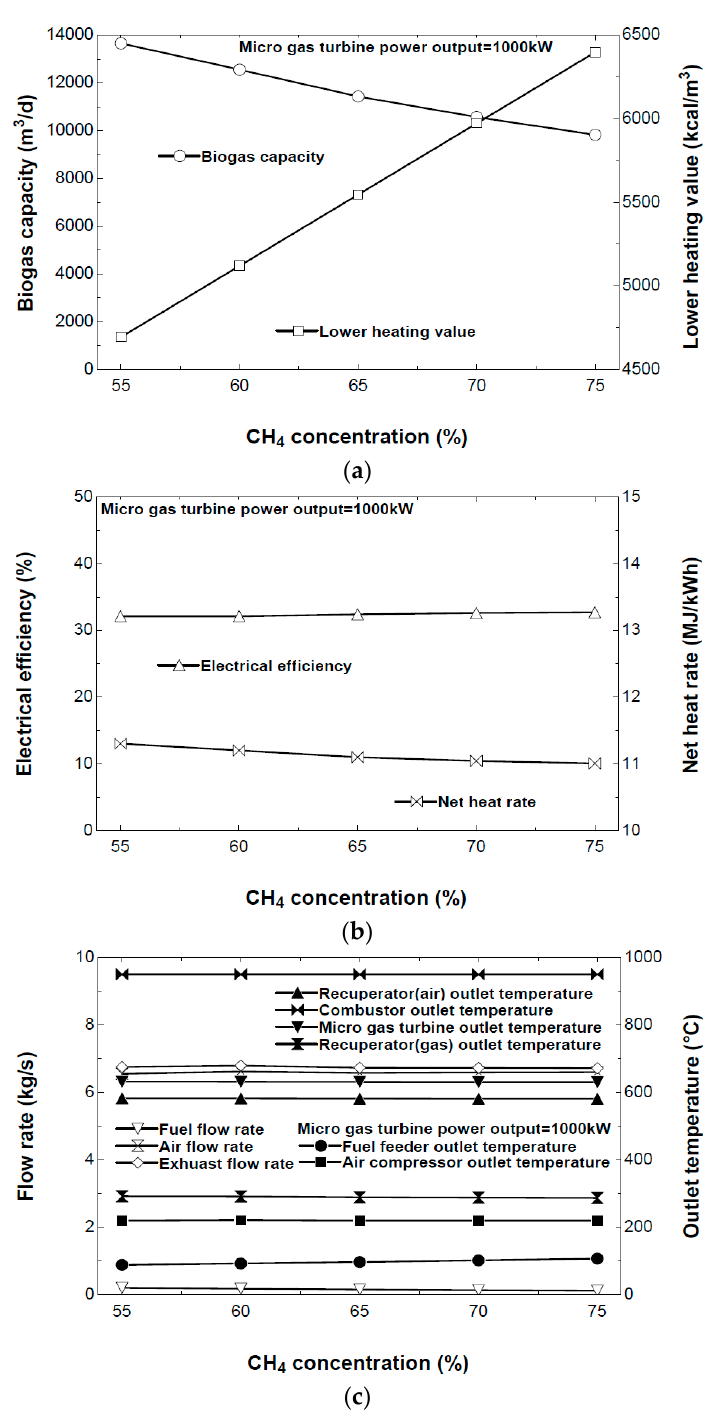
Figure 4. The effect of CH 4 concentration on the performance of the micro gas turbine. ( a ) The required biogas capacity per day and the lower heating value of the biogas; ( b ) The electrical efficiency and the net heat rate of the MGT; ( c ) The mass rate and the outlet temperature for the streams in the MGT.